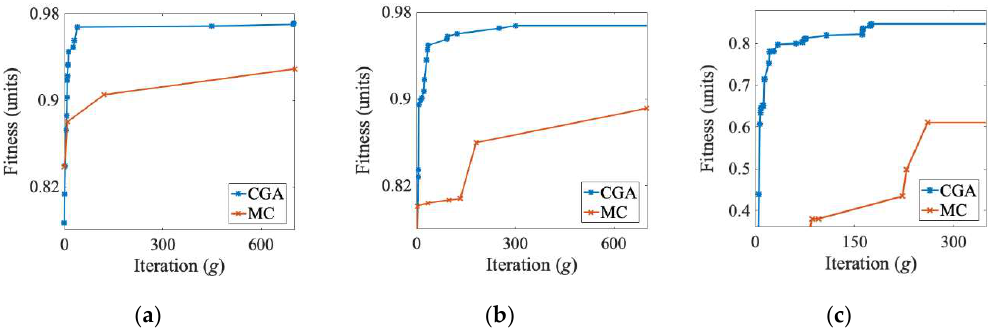
Figure 5. Fitness function improvements of the MC simulations vs. the CGA with fitness function coefficients equal ( a ) γ = 1, φ = 1; ( b ) γ = 1, φ = 10; ( c ) γ = 10, φ = 10. coe ffi cients equal ( a ) γ = 1, ϕ = 1; ( b ) γ = 1, ϕ = 10; ( c ) γ = 10, ϕ =